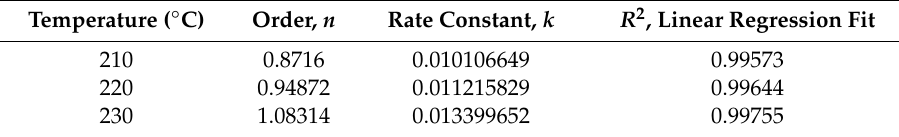
Table 3. Reaction kinetics calculated using data acquired at 210, 220, and 230 ◦